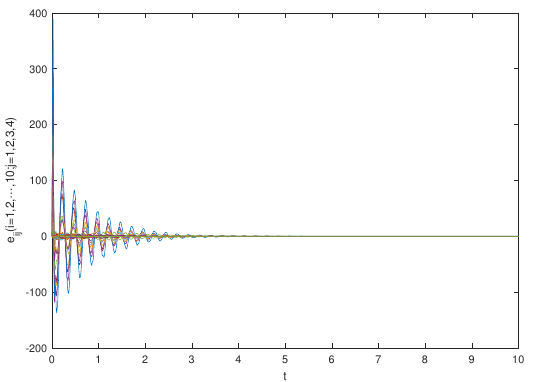
Figure 20. Synchronization errors e ij ( i = 1,2, · · · ,10; j = 1,2,3,4 ) of the fractional-order system (34) and (35) with the